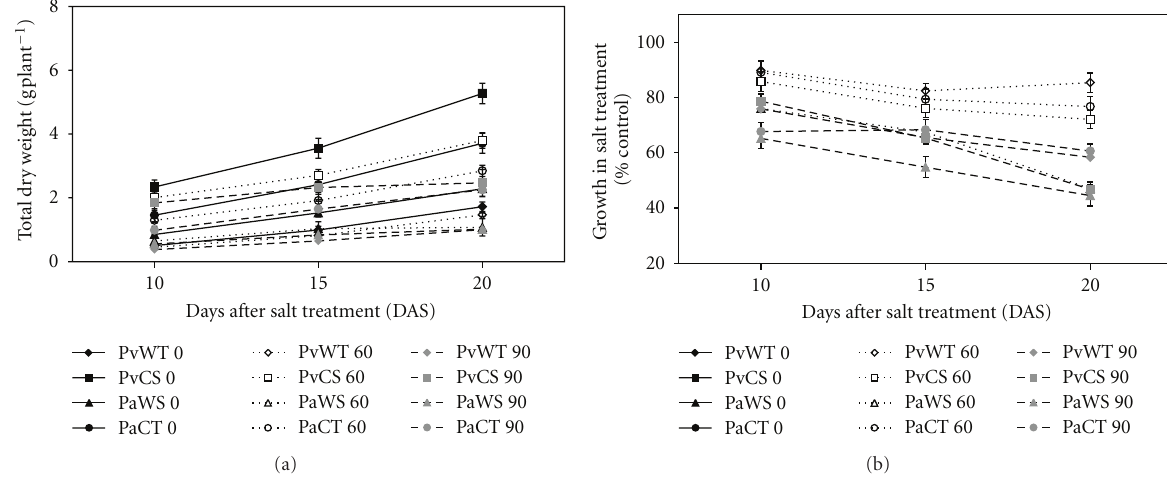
Figure 1: E ff ects of 0, 60, and 90mM NaCl on total dry weight (a) and percentage total dry weight (b) in salt relative to control conditions between 10 and 20 days after salt treatment for P. vulgaris PI325687 (PvWT), P. vulgaris G04017 (PvCS), P. acutifolius G40169 (PaWS), and P. acutifolius G40142 (PaCT). Each value represents the mean ± SE of six replicates.